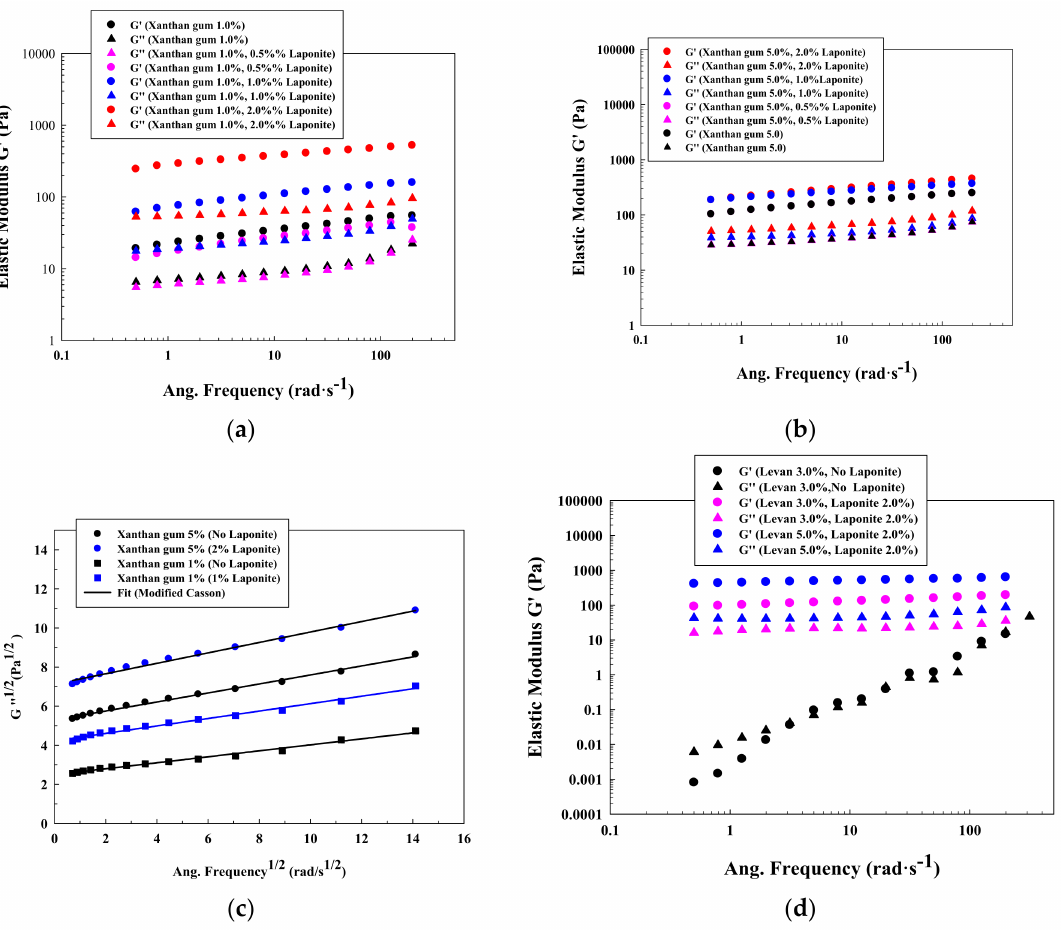
Figure 6. Oscillatory plots for different polysaccharides solutions: ( a ) xanthan gum 1.0% w / w ; ( b ) xanthan gum 5.0% w / w ; ( c ) modified Casson model for xanthan gum solutions; ( d )